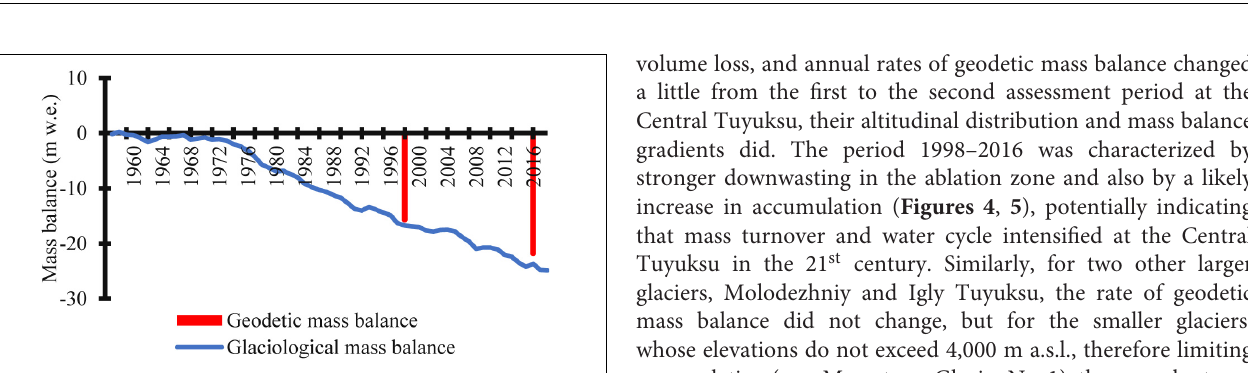
FIGURE 7 | Annual rates of change in the surface elevation of glaciers of the Tuyuksu group (m a − 1 ): (A) 1958–1998; (B) 1998–2016; (C) 1958–2016. The numbers are the same as in Figure 6 .